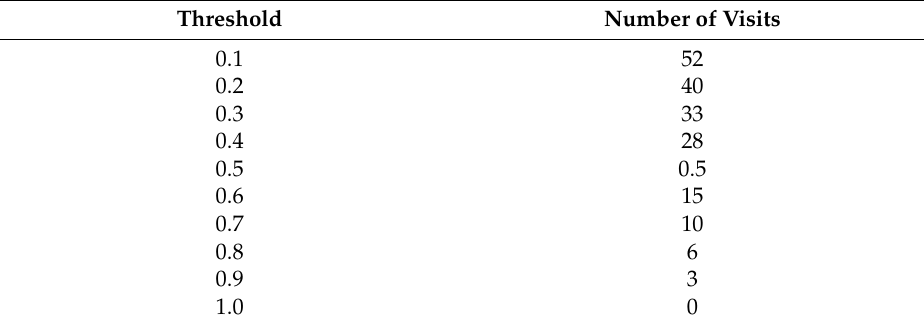
Table 5. The relationship between the threshold imposed by the user and the number of access